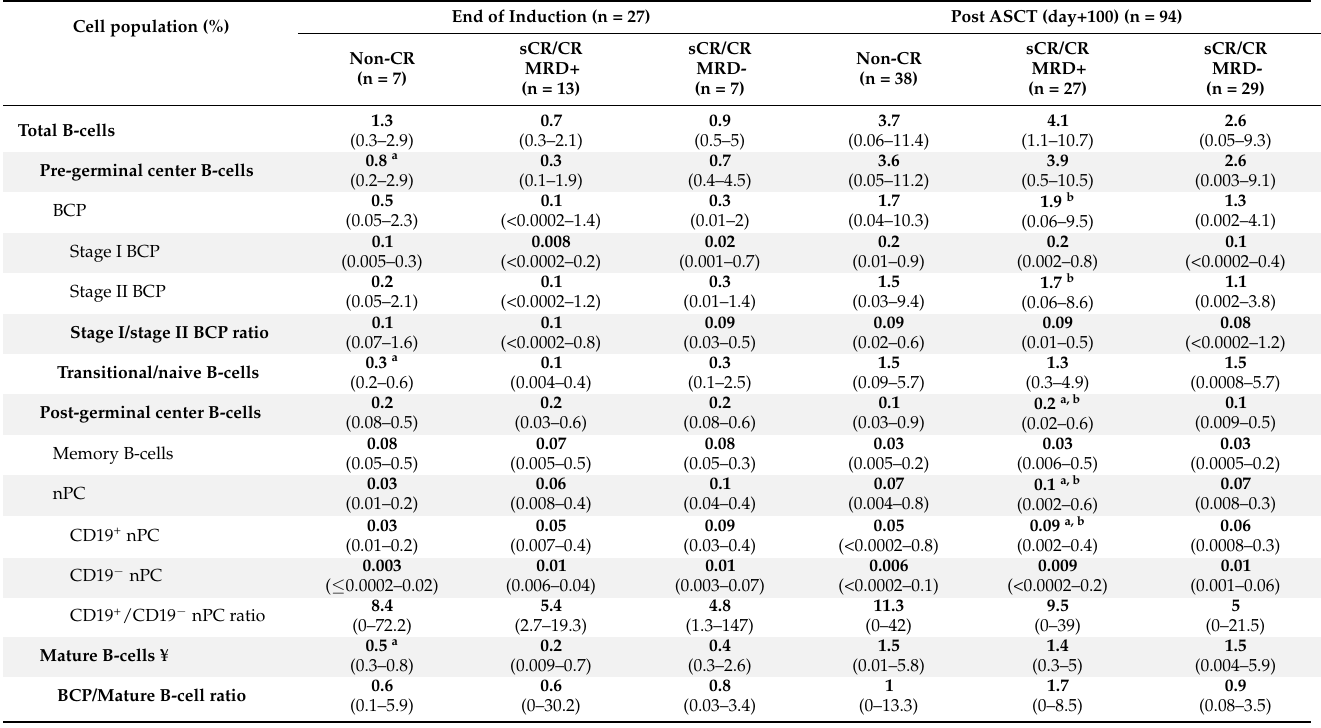
Table 2. Distribution of normal/residual B-cell populations in BM of treated MM patients according to their response status studied at different time points after/during